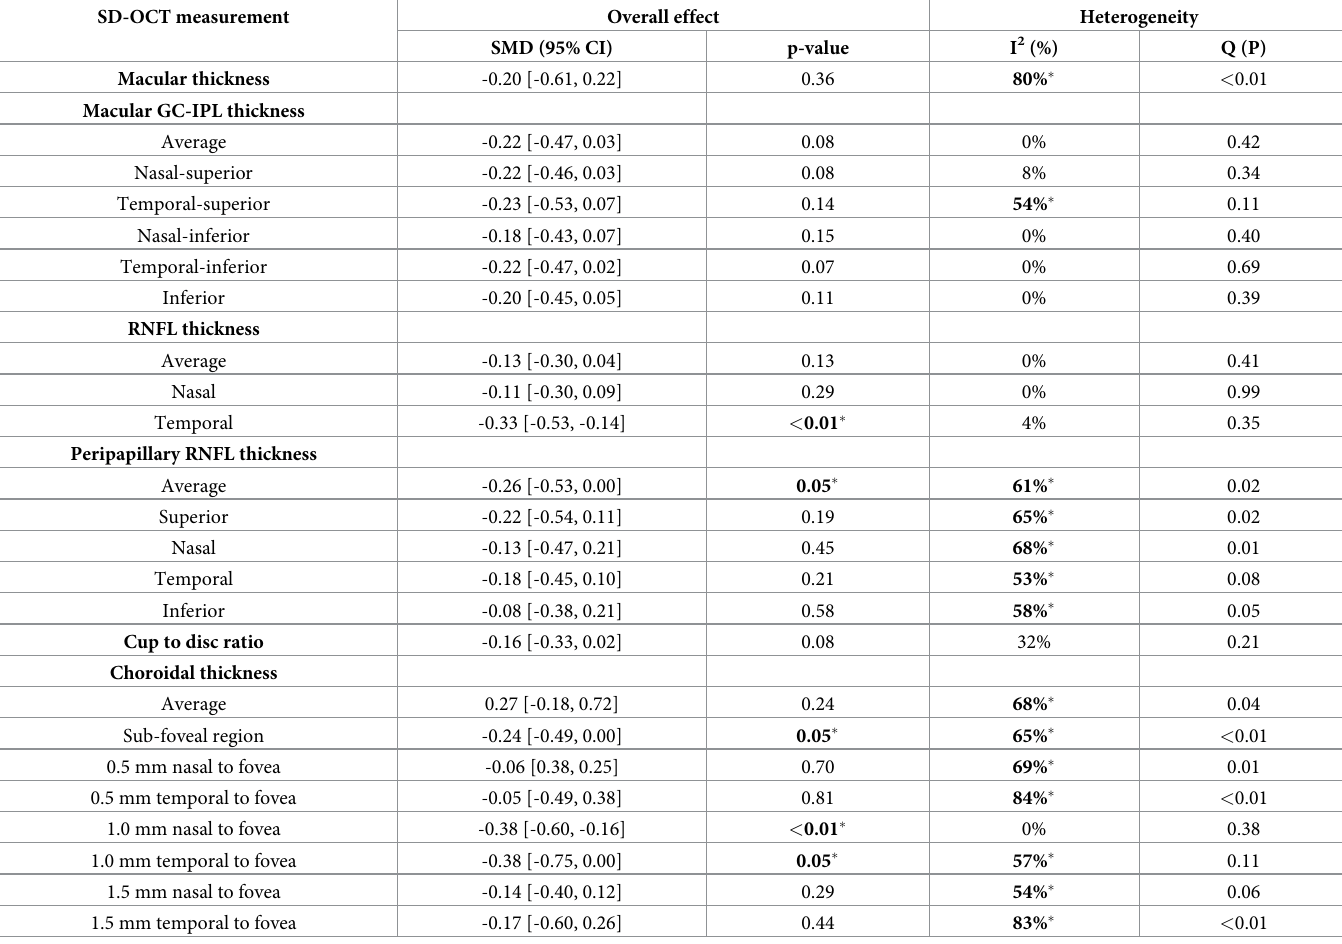
Table 2. Comparing ocular layers between patients with higher BMI and normal weight patients based on SD-OCT measurements. SD-OCT